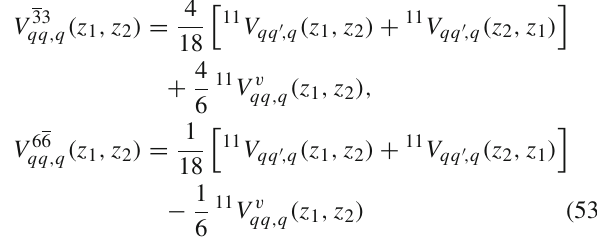
Here the convolution V ( z 2 , z 1 ) ⊗ f ( z ) is defined as in (46) with u and 1 − u interchanged on the r.h.s. In the last term of (51) we used the relation V ¯ qq (cid:3) , ¯ q = V q ¯ q (cid:3) , q from charge conju- gation invariance. Notice that the kernel 11 V qq (cid:3) , q includes an overall factor a 2 s